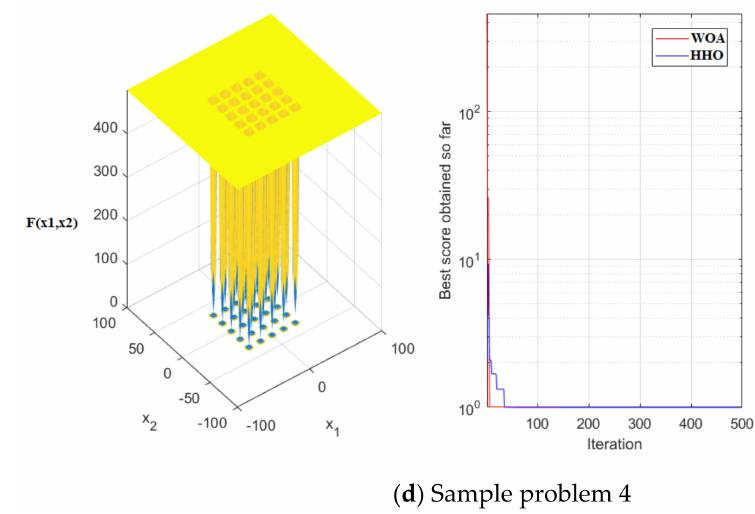
Figure 14. Evaluation of optimization models (WOA and HHO) to solve various problems.